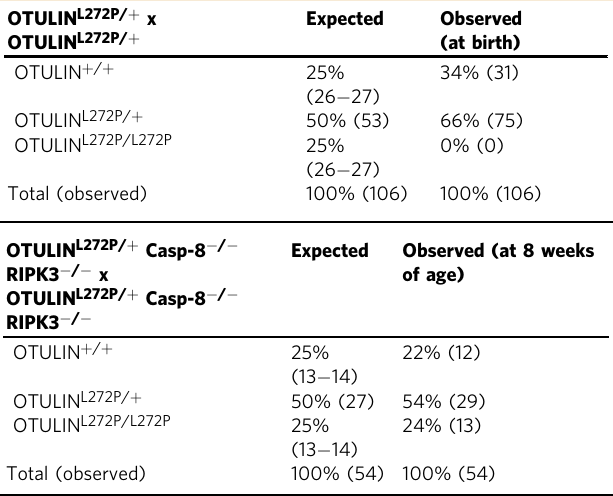
probed with antibodies against OTULIN (1:1000, Cell Signaling Technology, 14127), JNK (1:1000, BD Bioscience, 554285), phospho-JNK (1:1000, Millipore,